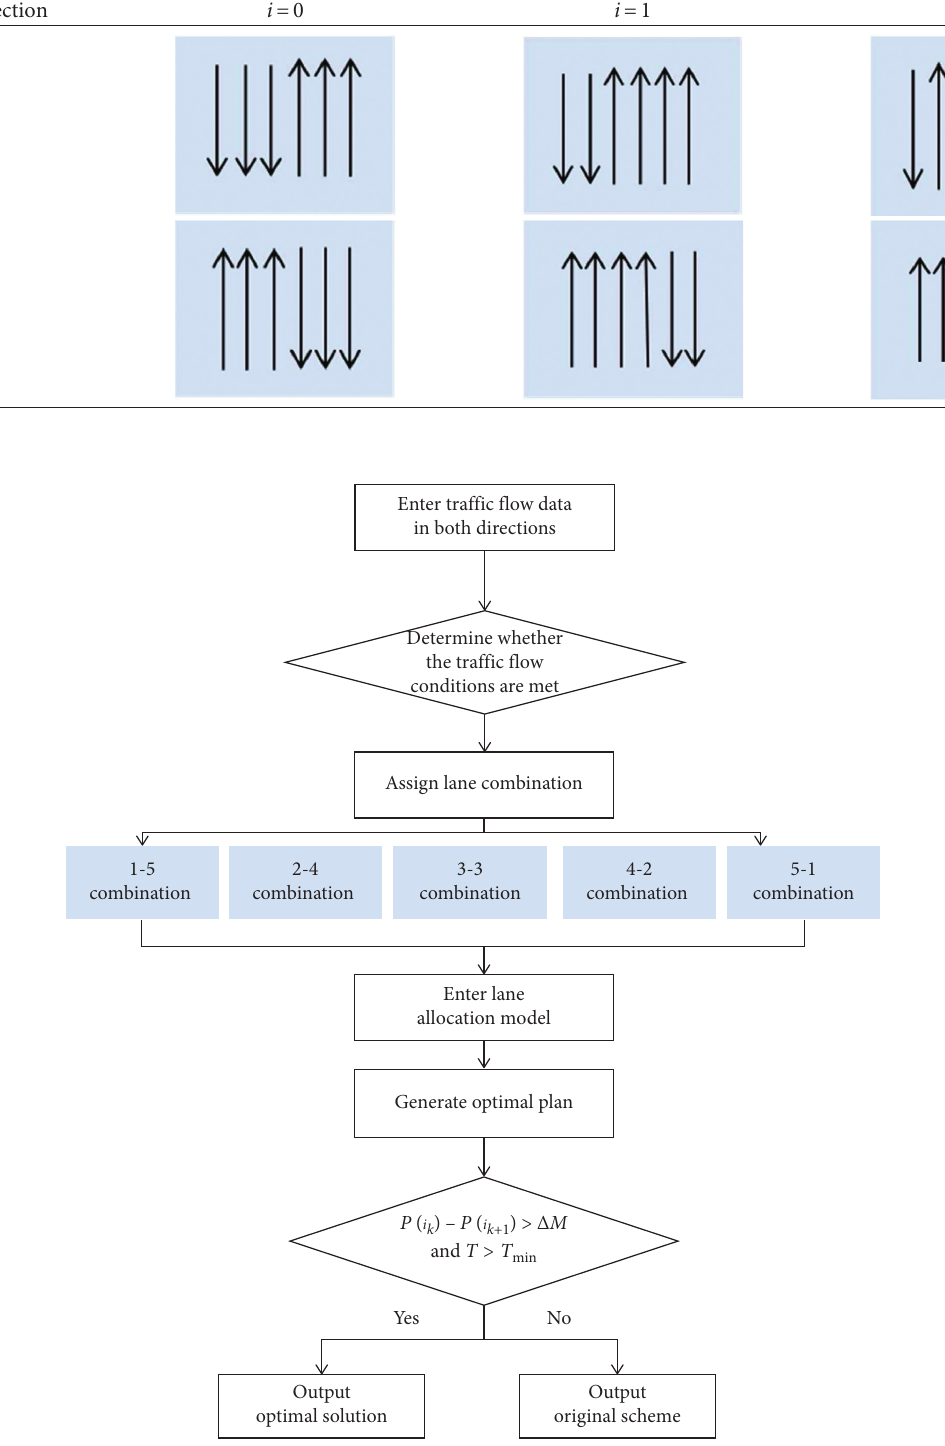
Figure 1: Flowchart of the reversible lane allocation model of the road